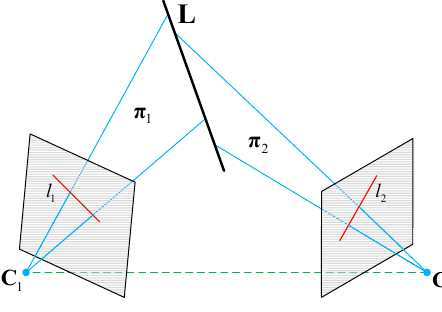
Figure 7. Geometric configuration of plans intersection.